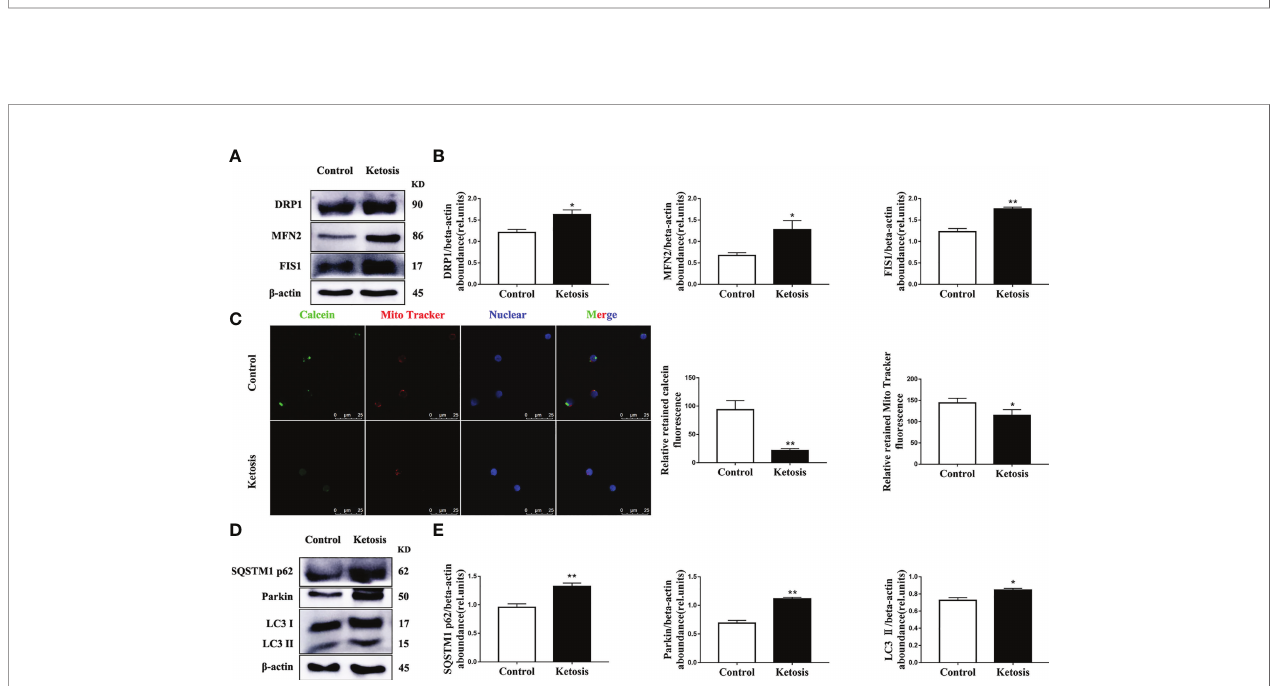
FIGURE 4 | Increased abundance of mitochondrial dynamics-related protein and autophagy-related protein, and impaired mitochondrial membrane permeability. (A) Western blot analysis of mitochondrial dynamics-related protein in CD4 + T cells from healthy and ketotic cows (n = 6 per group). (B) Relative abundance of mitochondrial dynamics-related protein (n = 6 per group). (C) Opening of mPTP was analyzed in healthy and ketotic cows (n = 3 per group; 3 random fi elds per group; scale bars, 25 m m). (D) Western blot analysis of autophagy-related protein in CD4 + T cells from healthy and ketotic cows (n = 6 per group). (E) Relative abundance of autophagy-related protein (n = 6 per group). For all bar plots shown, data are expressed as the means ± SEM, *P < 0.05, **P < 0.01 by independent- samples t-test.